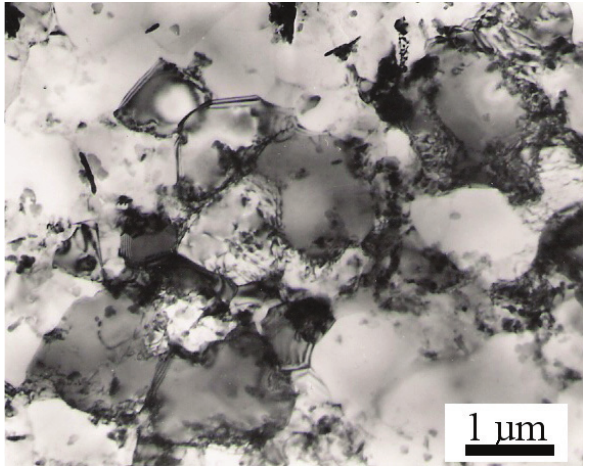
Figure 1. Sub-microstructure (foil) of Al-4Al 4 C 3 material after deformation (573 K) – transverse direction.